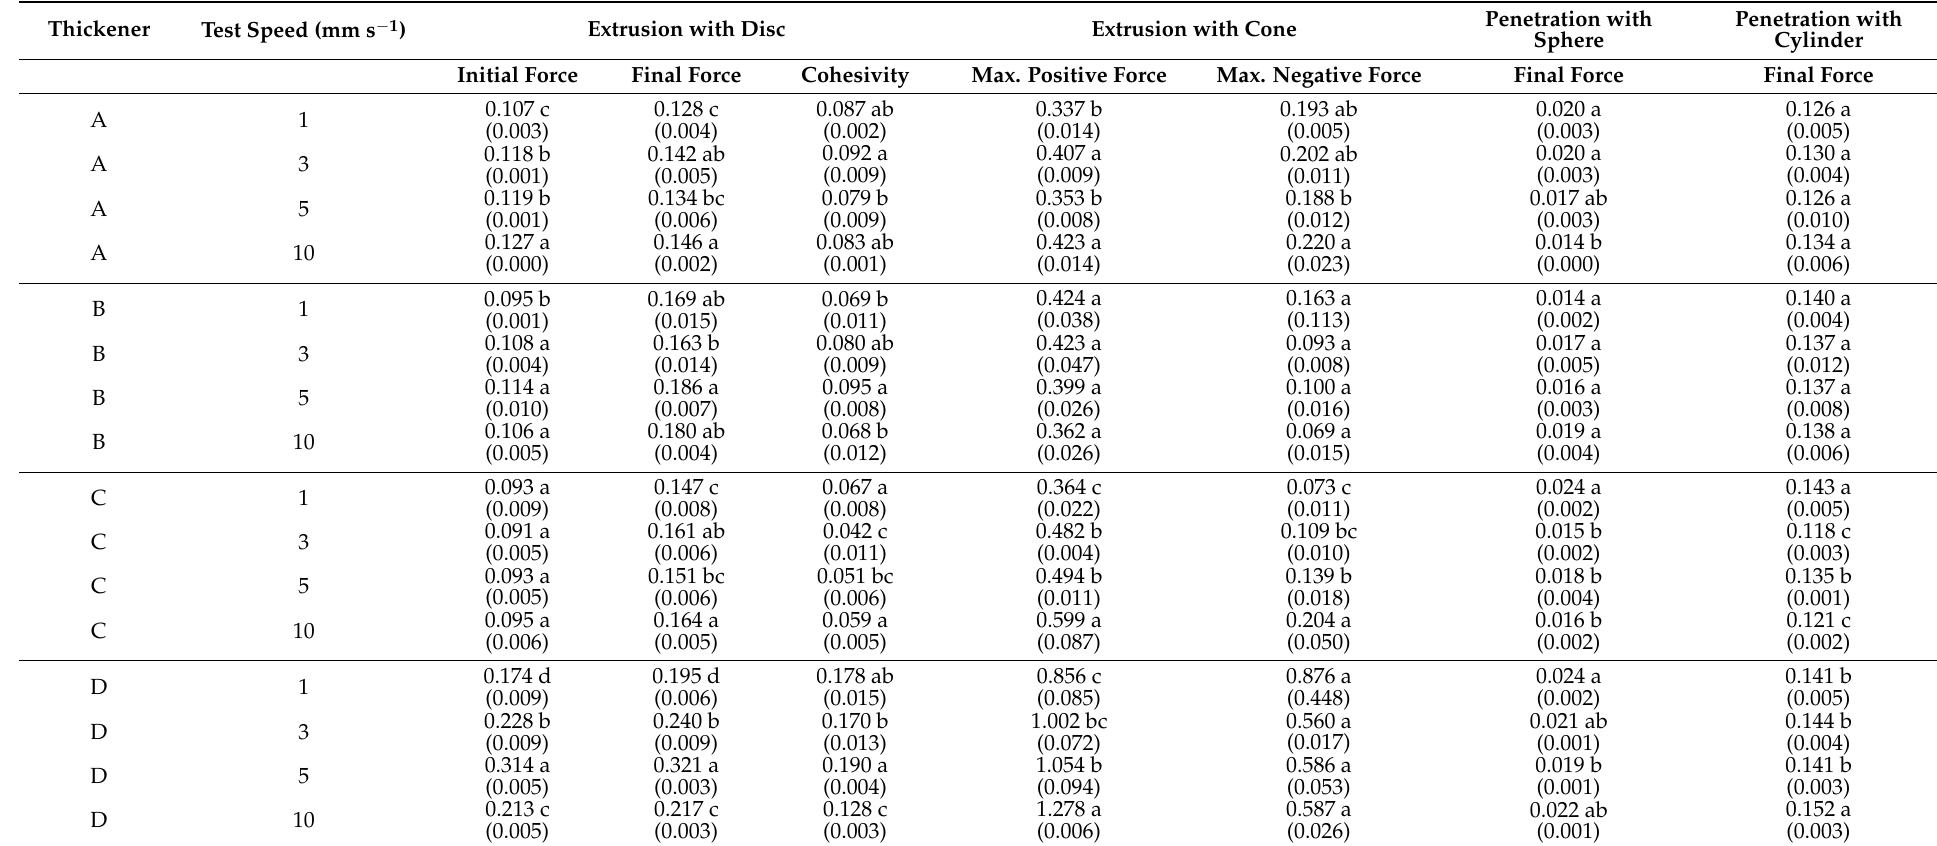
Table 6. Registered forces (in N) at different speeds for each thickener at the nectar level for the extrusion and penetration tests.